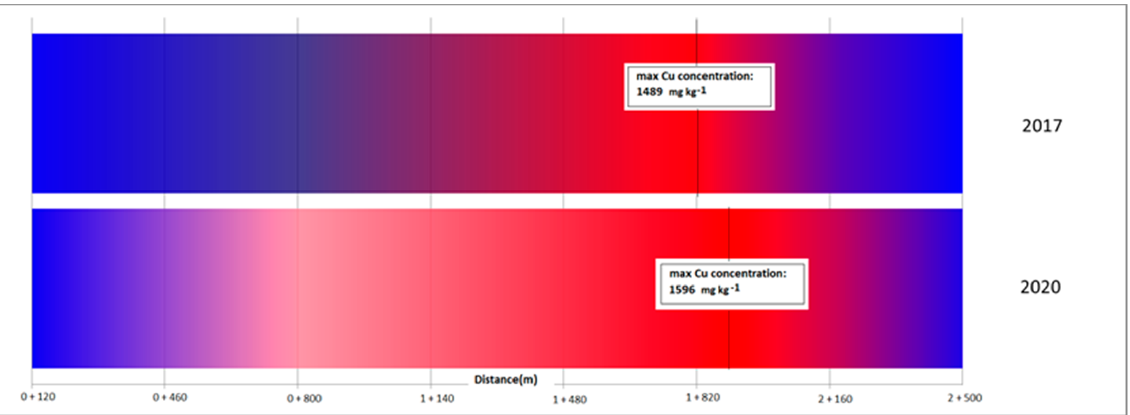
Figure 6. Field data of copper concentration along the canal in 2016–2017 and 2020.